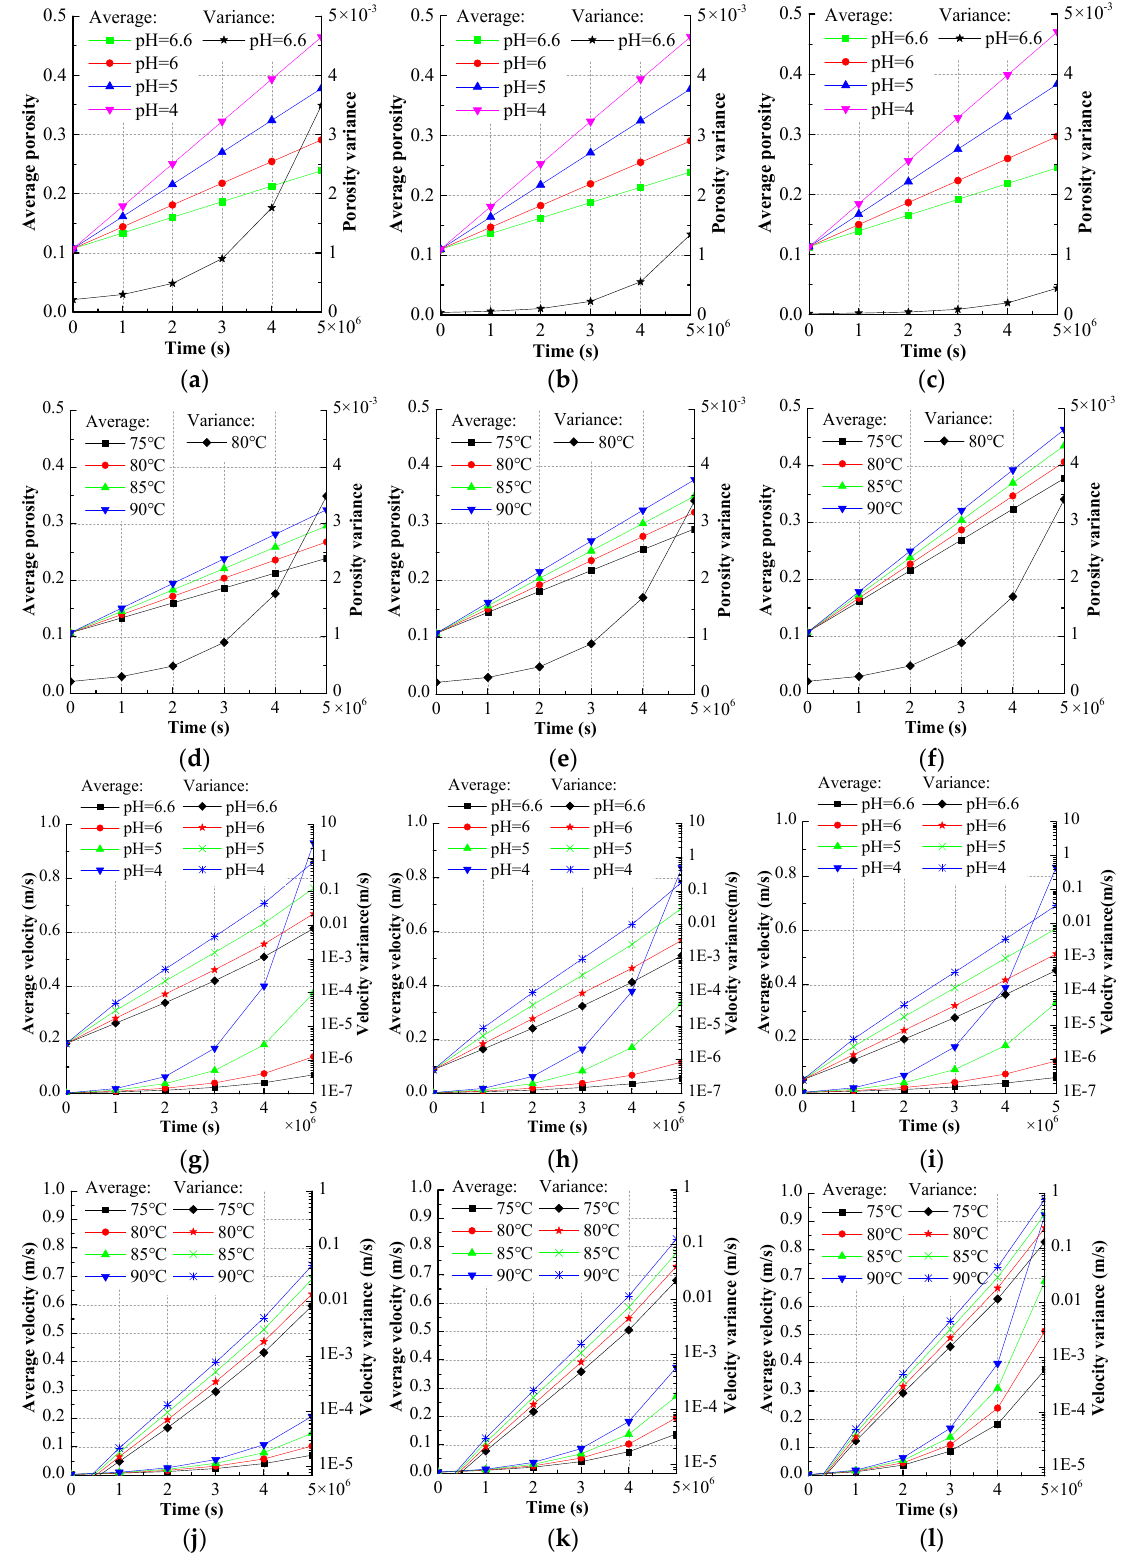
k = 2; ( b ) k = 5; ( c ) k = 8; ( d ) pH = 6.6; w w w